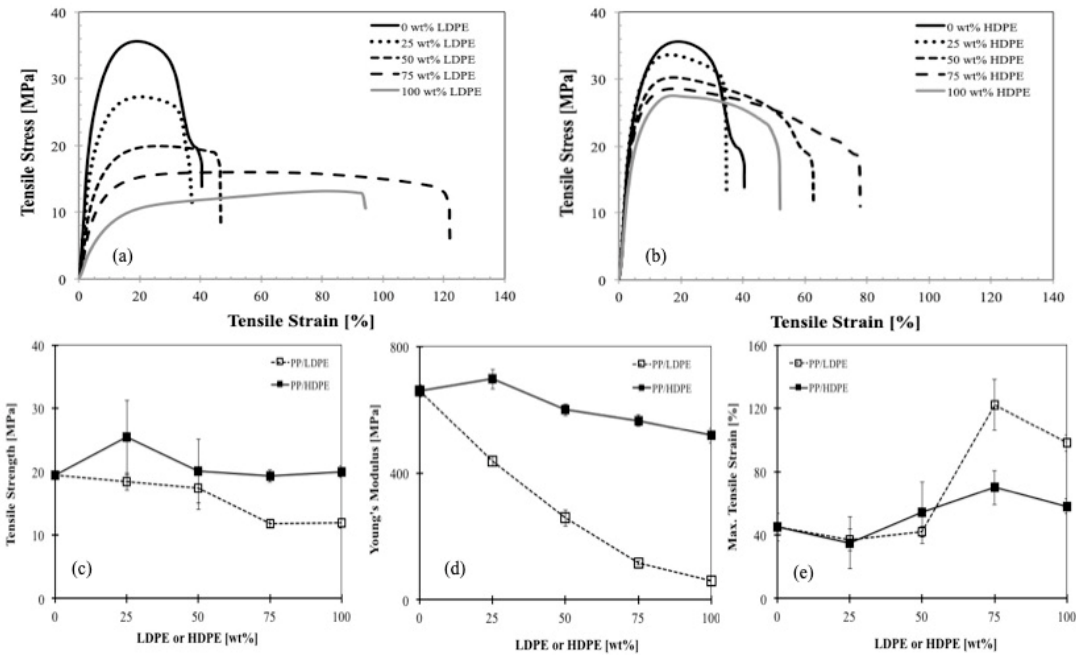
Figure 10. Tensile properties: ( a ) stress-strain curves of PP, LDPE and their blends at different compositions (u 0 = 500 mm/min), ( b ) stress-strain curves of PP, HDPE and their blends at different compositions (u 0 = 500 mm/min), ( c ) tensile stress, ( d ) Young’s modulus and ( e ) tensile strain at maximum stress for PP/LDPE (dash line) and PP/HDPE (solid line) as a function of blend composition.